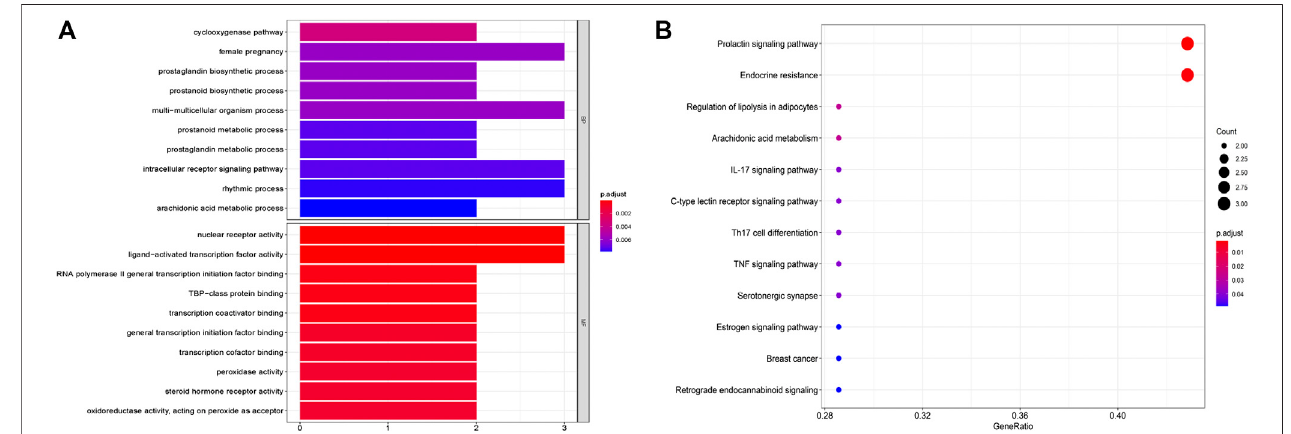
FIGURE 5 | GO and KEGG pathways enrichment analysis of candidate targets. (A) The biological processes and molecular function analysis of potential targets. (B) The enrichment analysis of the KEGG signaling pathways.